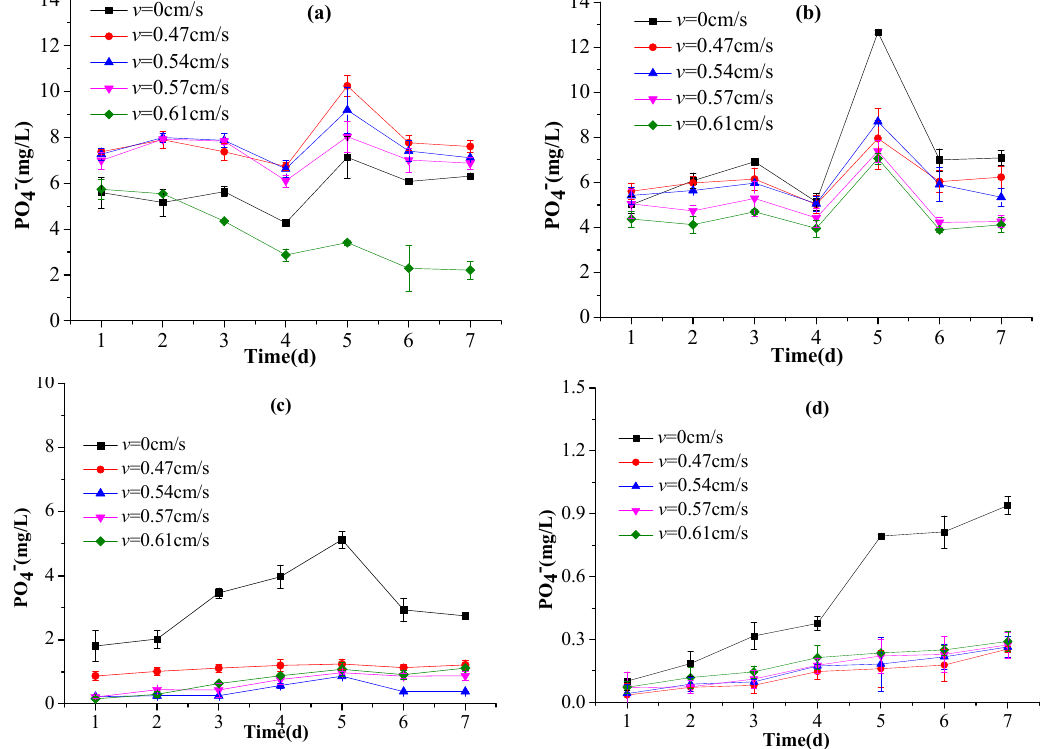
Figure 9. The concentrations of phosphate (PO 4 − ) at depths of: ( a ) 6 cm; ( b ) 3 cm; and ( c ) 1 cm within the sediments; and ( d ) in the overlying water, during the experiment.